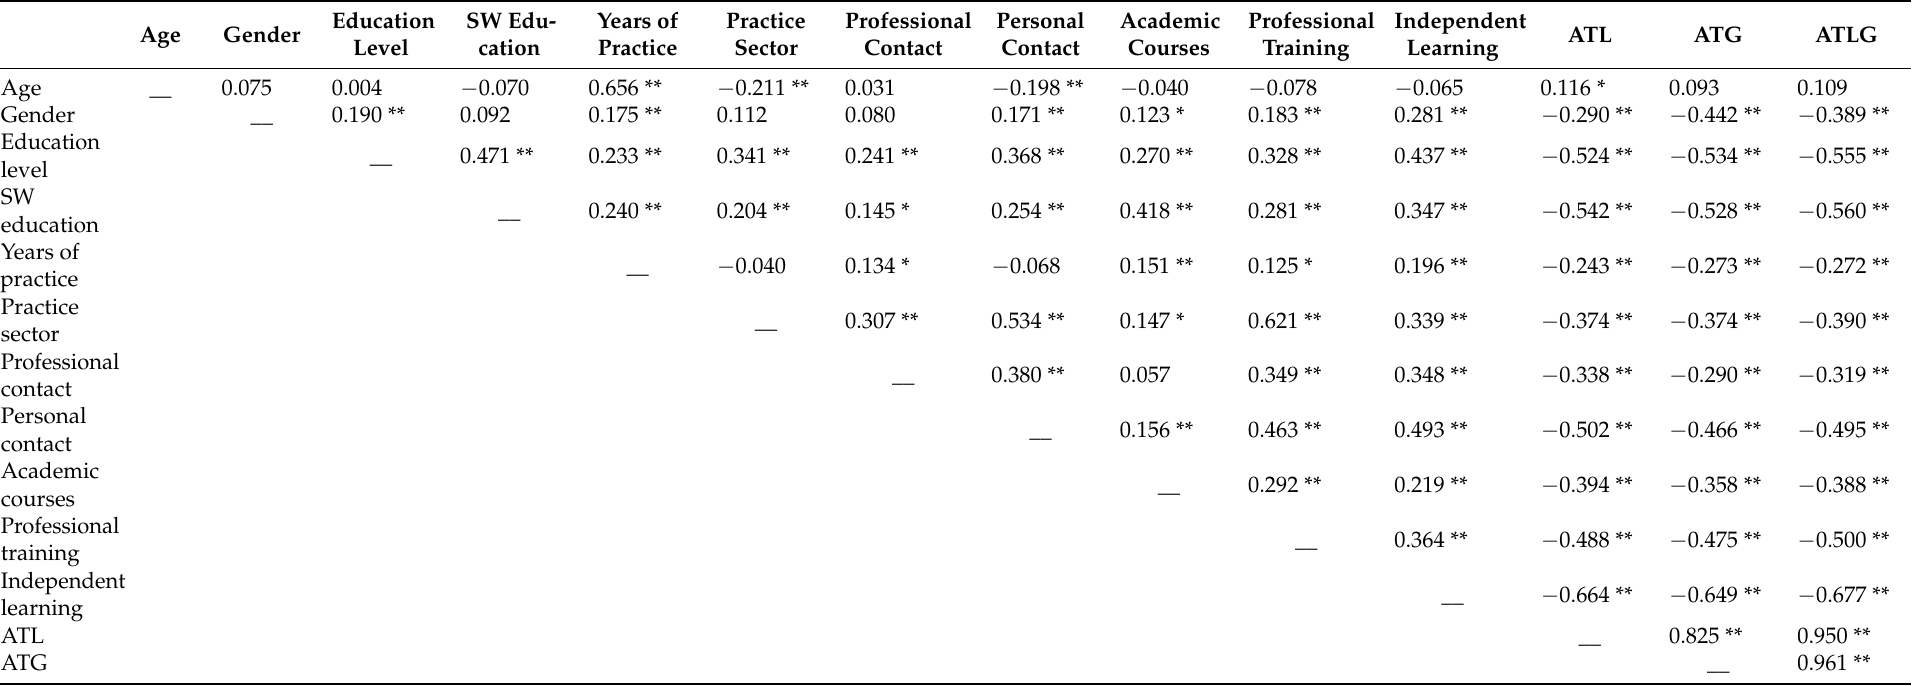
Table 2. Bivariate correlations